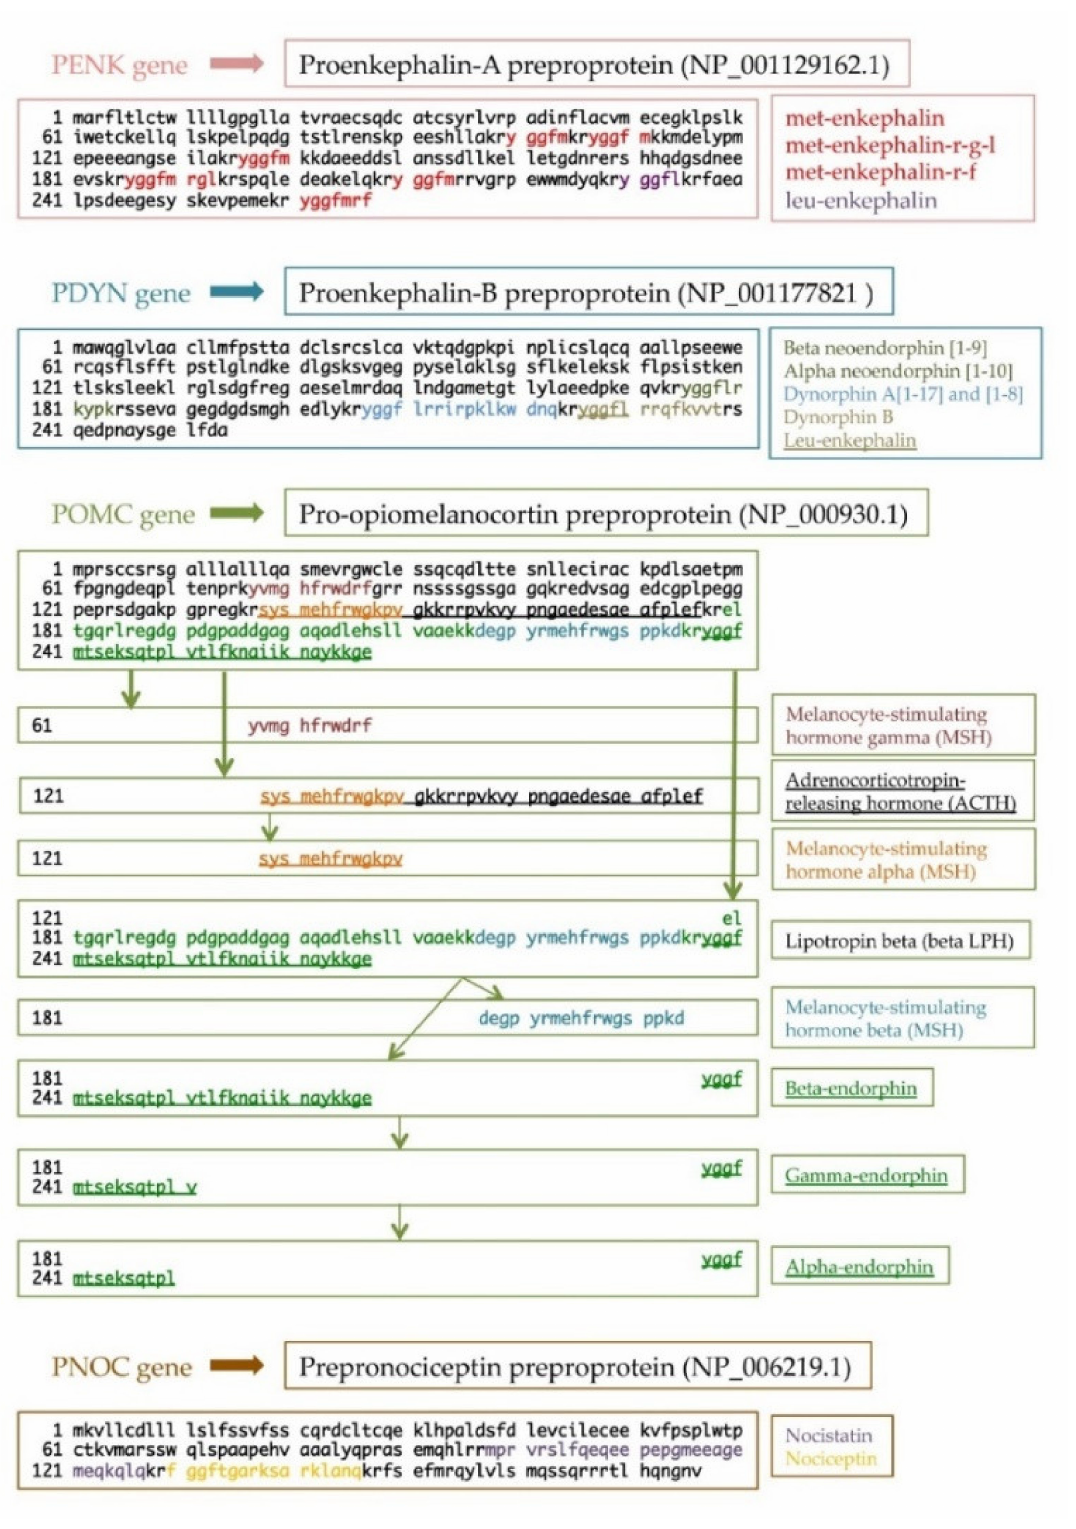
Figure 1. Schematic representation of human endogenous opioid families and their main functional peptides after precursor processing. For each family of peptides, the following information is reported: (i) the names of the genes ( PENK , PDYN , POMC , and PNOC ); (ii) the amino acid sequence of the preforms (NCBI Reference Sequence is reported in brackets next to the proform names); (iii) on the right, the names of the main functional peptides highlighted with a corresponding colour in the preform peptide sequence and in the isolated peptide sequence when it is